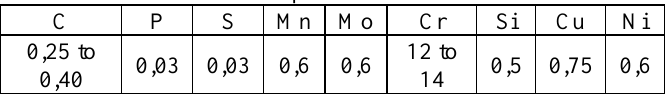
Table 3: Chemical composition of wires in the thermal spraying